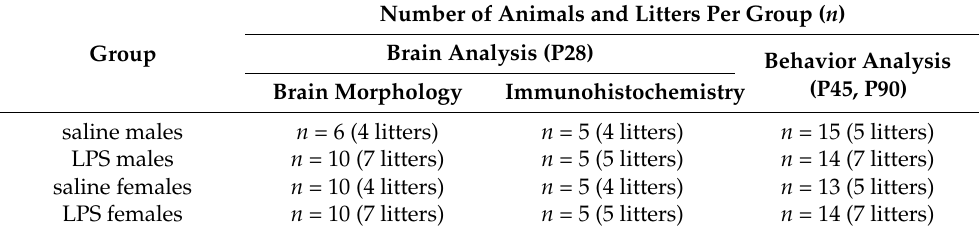
(P45, P90)Brain Morphology Immunohistochemistry